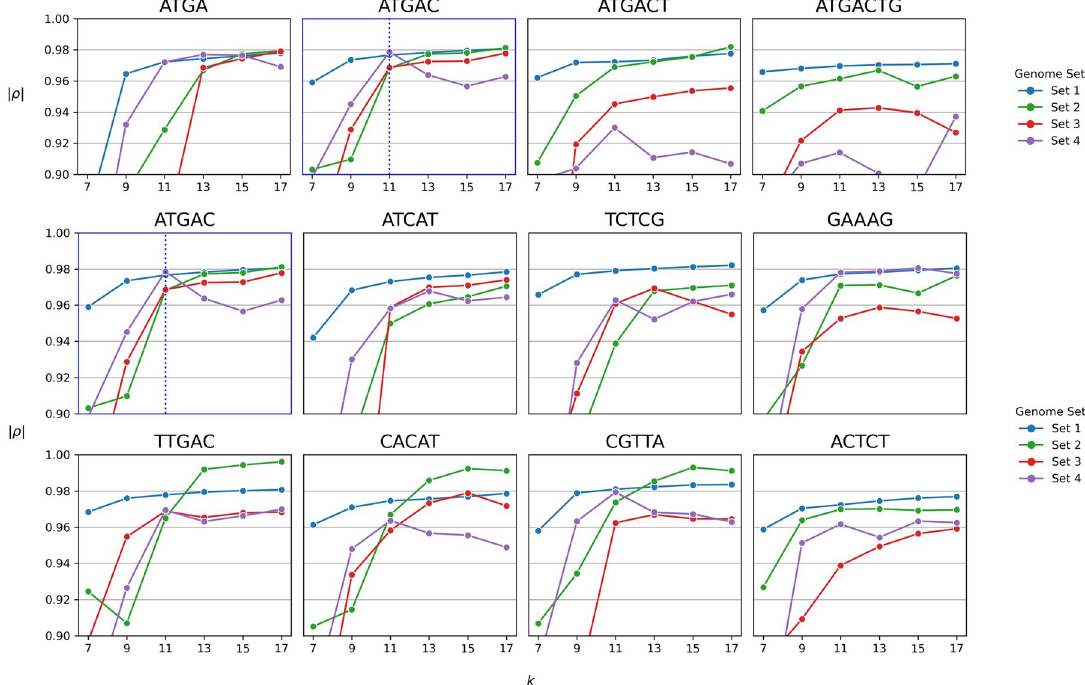
Fig 2. Spearman correlation between GAMBIT distance and ANI for different GAMBIT parameter values. Each subplot in both A and B represents a different choice of prefix sequence. Subplots show the absolute value of the Spearman correlation ρ vs. value of the k parameter for all pairwise comparisons within genome sets 1–4 (Table 1). Standard values of the prefix and k parameters used throughout the rest of the manuscript are highlighted by a blue subplot border and blue vertical line, respectively. A. Variations of our standard prefix ATGAC with length between 4 and 7 nucleotides. B. Standard prefix sequence plus 7 random sequences of the same length. See S1 Fig for the full set of variations in prefix sequence and length.